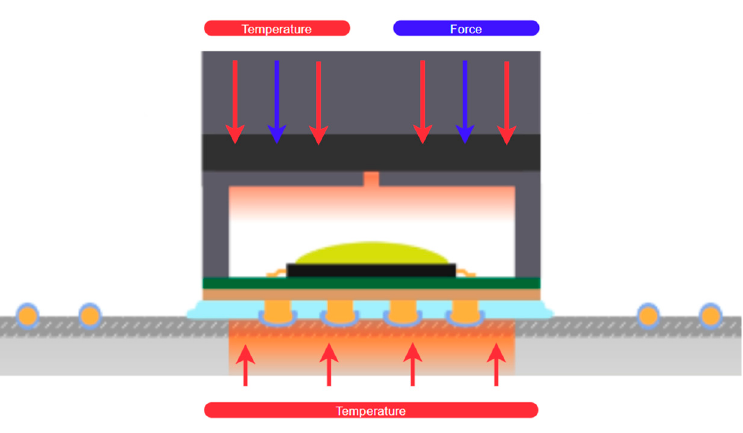
Figure 5. Schematic representation of the bonding process.